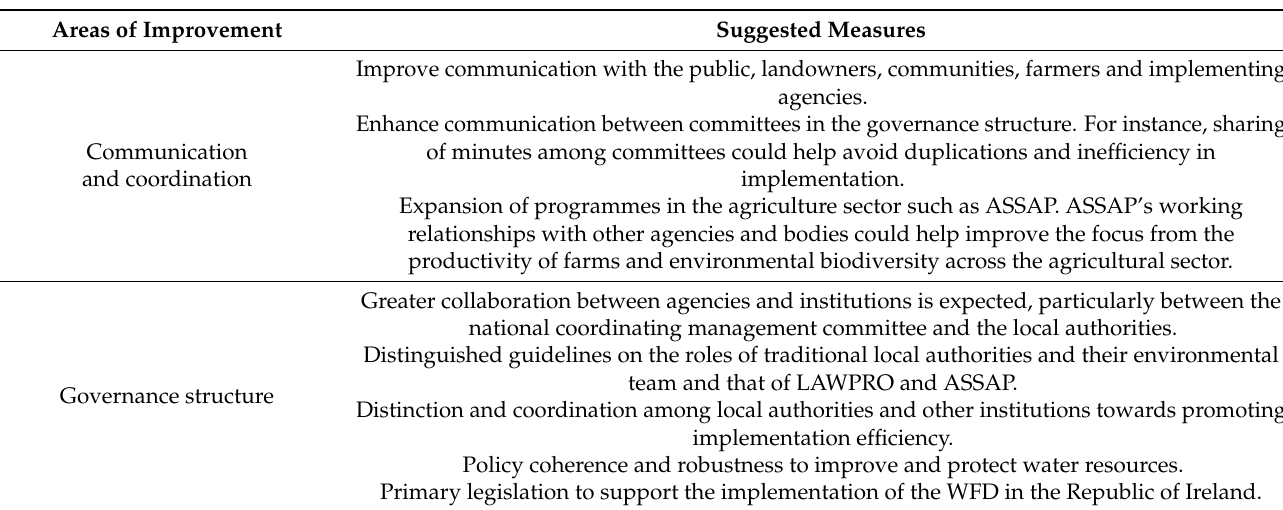
Table 2. Stakeholders’ expectations for areas of improvement in the third RBMP. Areas of Improvement Suggested Measures